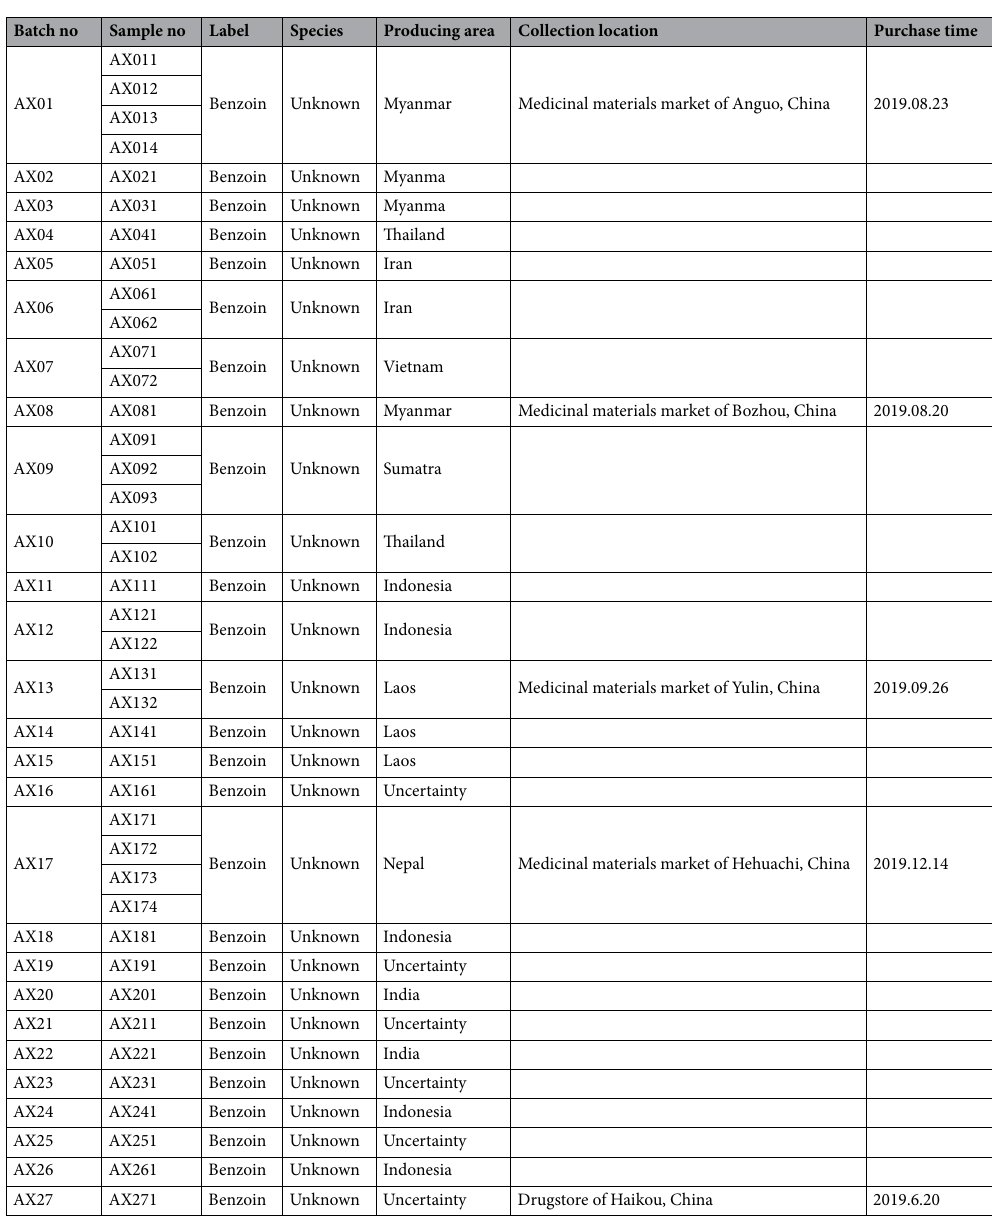
Table 6. Information on samples of benzoin was collected from medicinal markets and